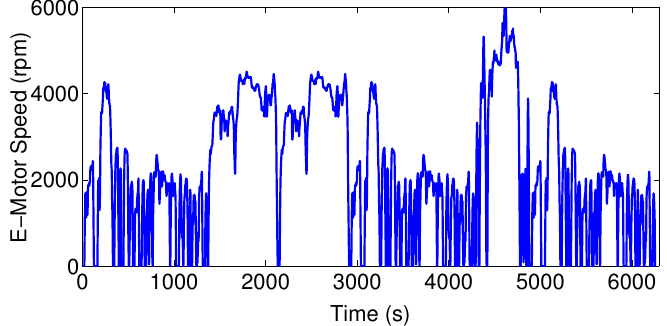
Figure 9. Traction E-motor speed during the combined driving